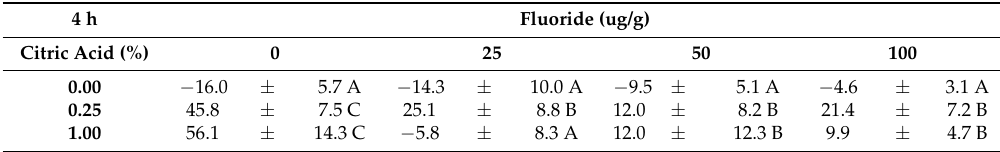
Table 2. Dentin surface lost due to erosion ( µ m) for each of the 12 experimental groups at 4 h of erosive exposure. Values are average ± standard deviation, n = 4 for each group. A positive mean value indicates the erosion loss, a negative mean value indicates a mineral gain on the surface. The letters associated with each experimental group (A, B, or C) designate experimental groups that are statistically different at p < 0.05 (groups with the same letter are not statistically different) as determined by two-way ANOVA followed by post hoc ranked comparisons.